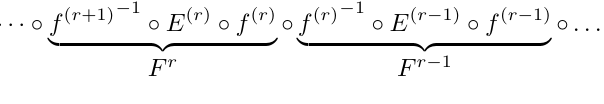
Figure 1: The CEJO